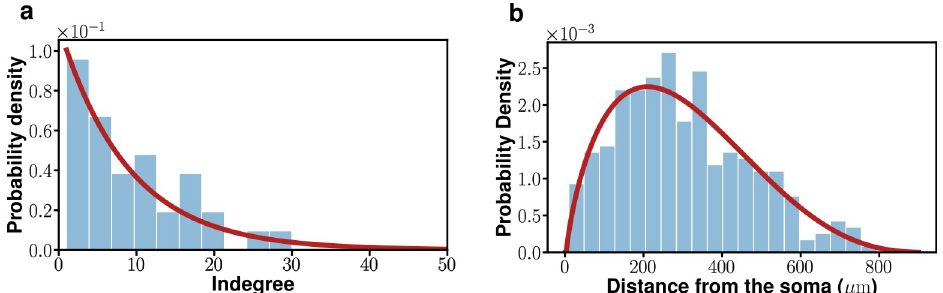
Fig 2. Indegree k in probability density function ( pdf ) (a) and pdf of the distances to pre-synaptic neurons (b) of neonatal SCN clock cells. The solid red line in (a) is a fit to an exponential pdf (with a mean of 8.9). The distance in (b) refers to the relative Euclidean distance from a postsynaptic neuron to its presynaptic neuron(s) (solid red line: a fit to beta pdf ; the median is ~205 μm ). (This figure is adapted from Ref.